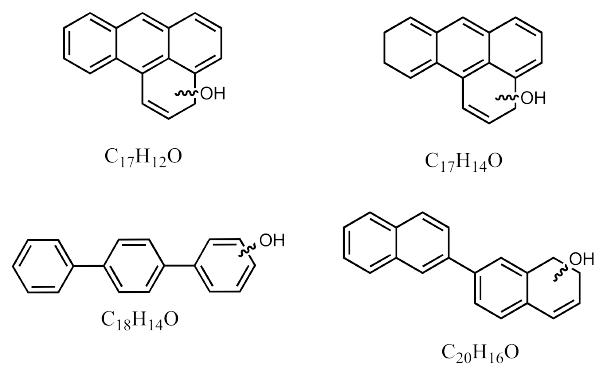
Fig. 3. Proposed condensed aromatic hydrocarbon structures based upon the assigned molecular formulas. The position of the hydroxyl group is uncertain as indicated by the wavy bond on the